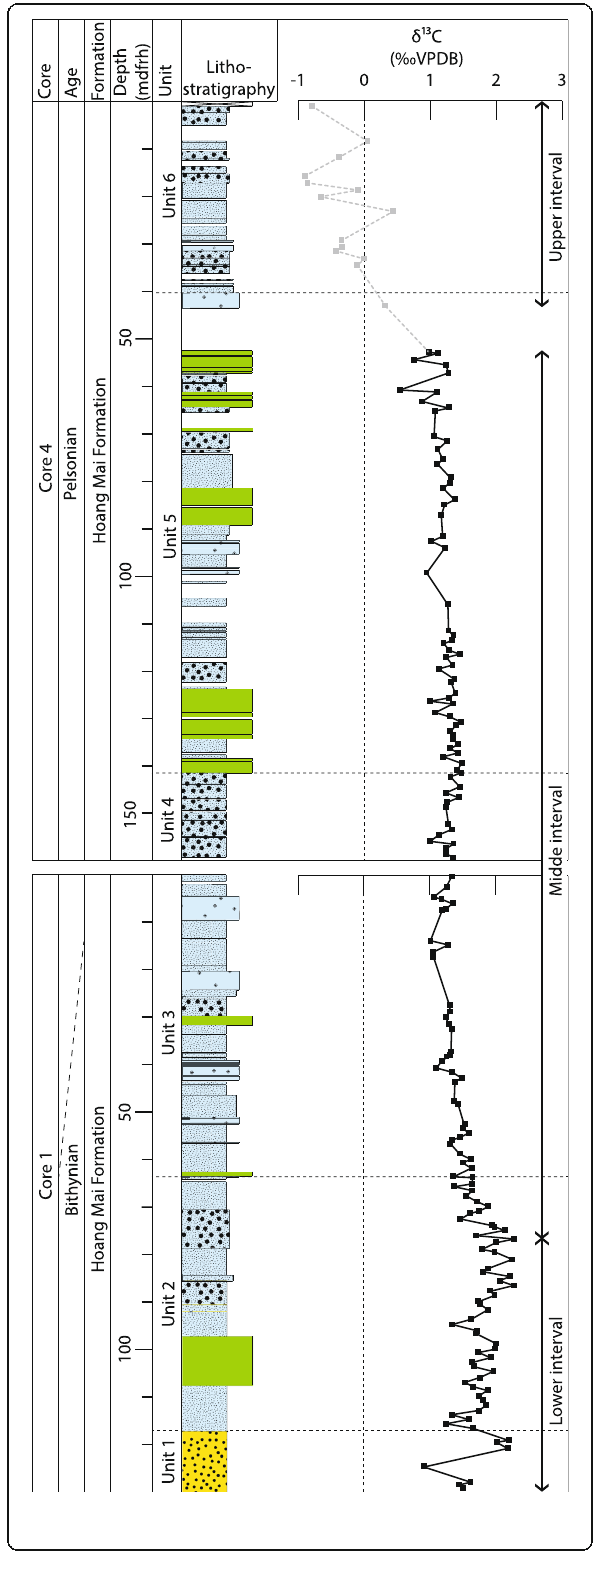
Fig. 6 Composite lithostratigraphy and carbon isotope stratigraphy of bulk carbonate samples from this study (cores no. 1 and 4). The δ 13 C values presented are those of samples that are not diagenetically altered, as inferred from trace element (Mn and Sr) criteria as defined in the subsection “ Isotope and minor element profiles ” of the main text. Using these criteria, 67 samples were removed from consideration (Additional file 1: Table S1 and Additional file 2: Table S2). The marked decrease observed in the δ 13 C profile in the upper interval (uppermost unit 5 and unit 6; shown in gray) is likely due to diagenetic overprinting (meteoric diagenesis). For the definition of the pink and blue areas and abbreviations, see the Fig. 2